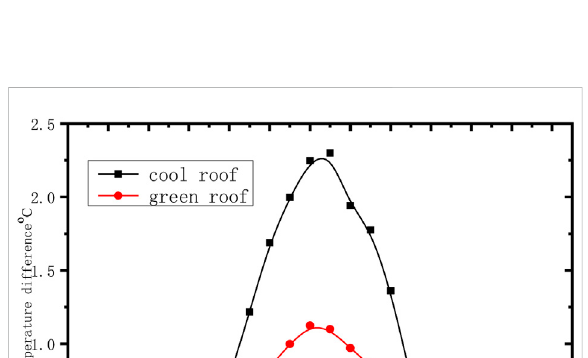
FIGURE 11 Ambient air temperature with different roofs in hot summer and cold winter zones.